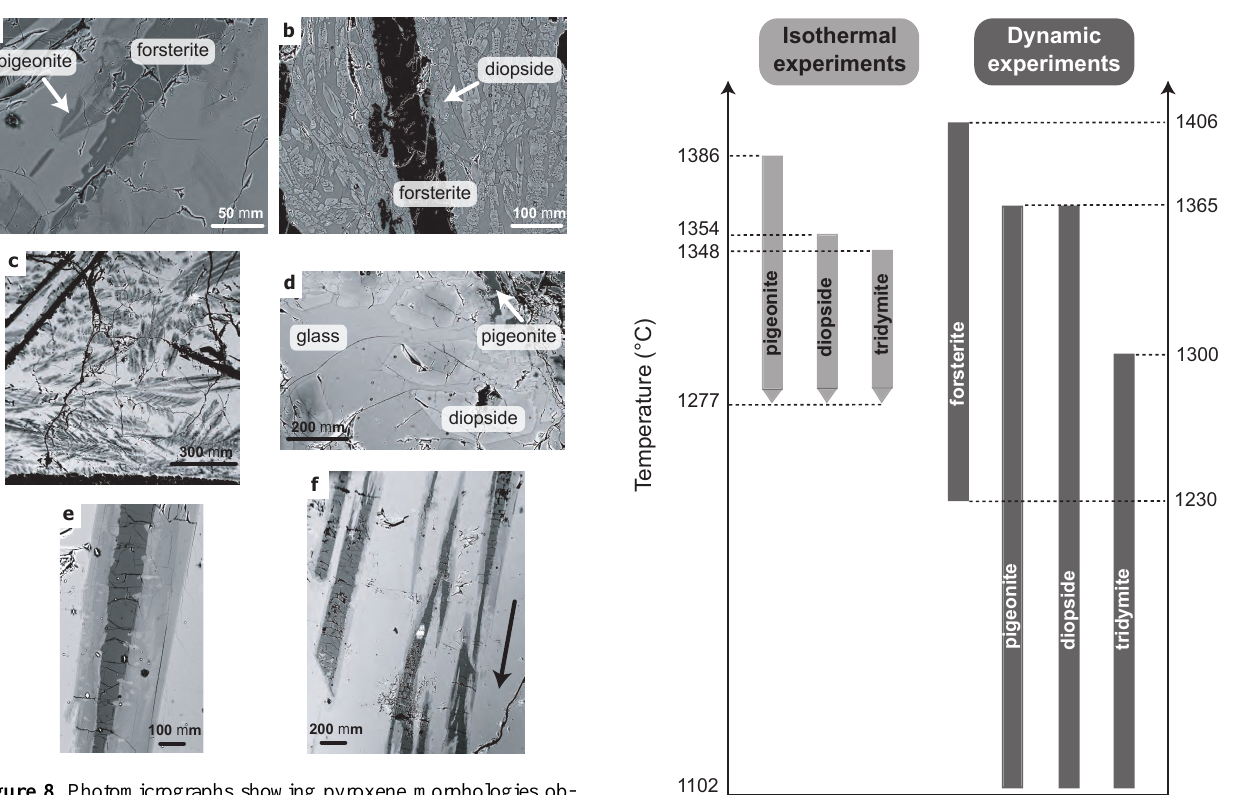
Figure 9. Range of crystallization temperatures of silicate phases Fig. 9. Range of crystallization temperatures of silicate observed in both isothermal and dynamic phases observed in both isothermal and dynamic experiments.